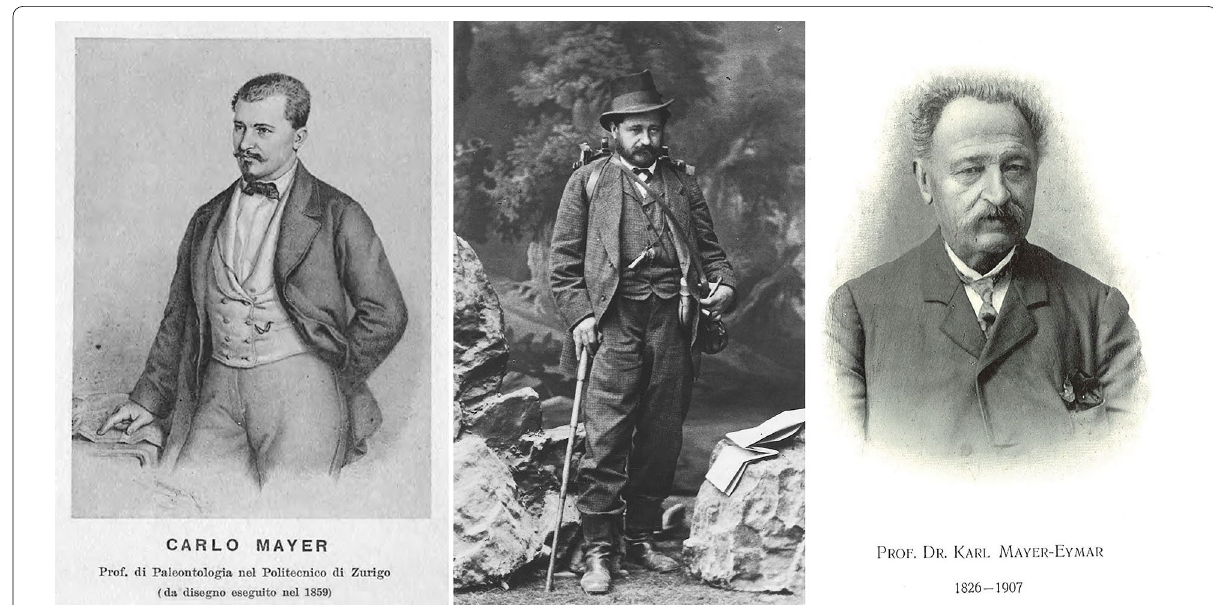
Fig. 1 Left: Karl Mayer at the age of 33 (from Sacco, 1907); middle: a rare photograph of Mayer in the field (source NMB); right: Karl Mayer-Eymar at the age of around 75 (from Heim & Rollier,